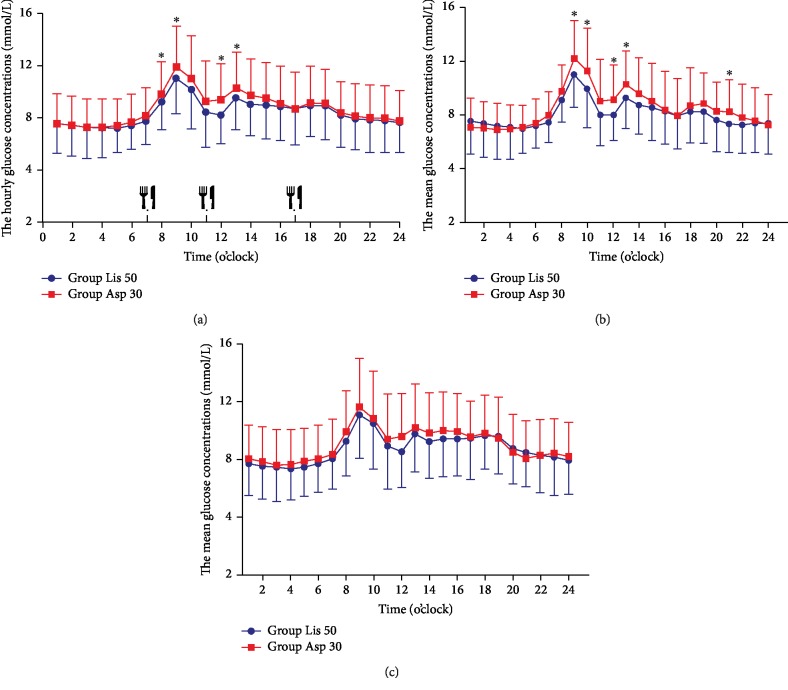
The average blood glucose concentrations per hour in all patients. ∗p < 0.05.